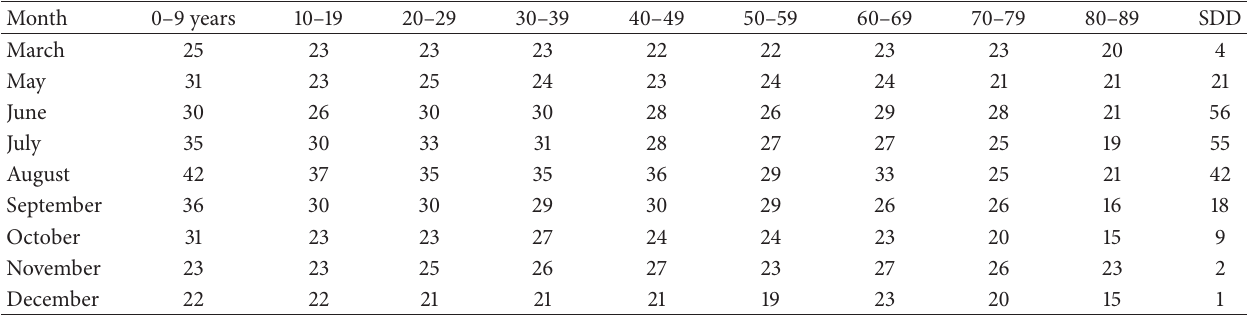
Table 5: Serum 25(OH)D concentration (ng/mL) versus age range and month measured for patients at Semmelweis University, Budapest, 3 between April 2009 and March 2010